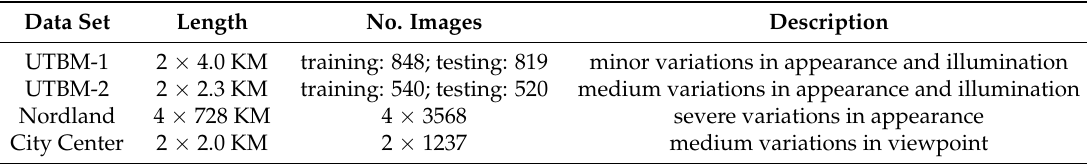
Table 2. Descriptions of the main characteristics of the data sets employed in the